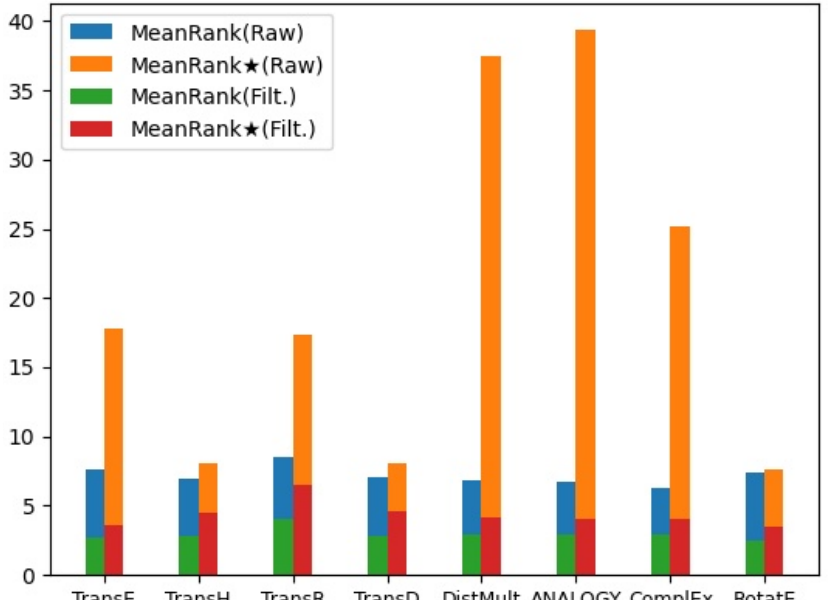
Figure 7. The influence of the relations between factors in the schema on the learning effect of multiple base model representations.